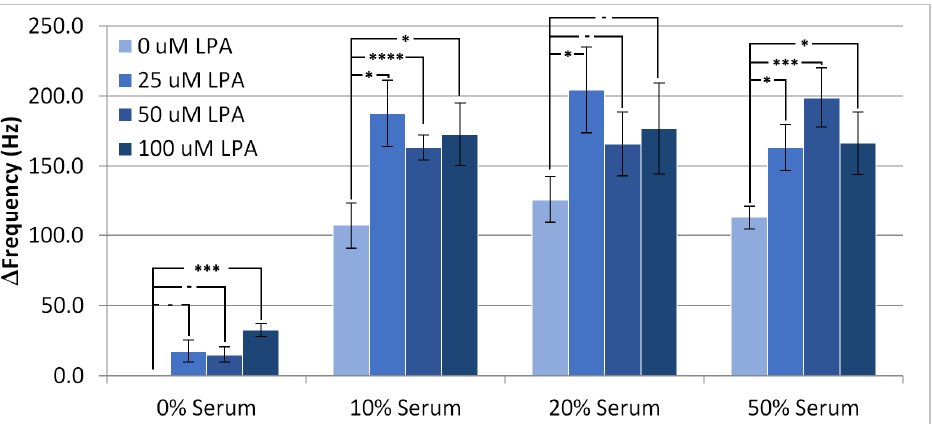
Figure 3. Change in frequency of the TSM from the baseline in PBS buffer to the final wash for experiments conducted with PBS/serum solutions containing LPA. Statistical significance using t -test shown by asterisks: (-) no significant difference, (*) 90% confidence, (***) 98% confidence, (****) 99%